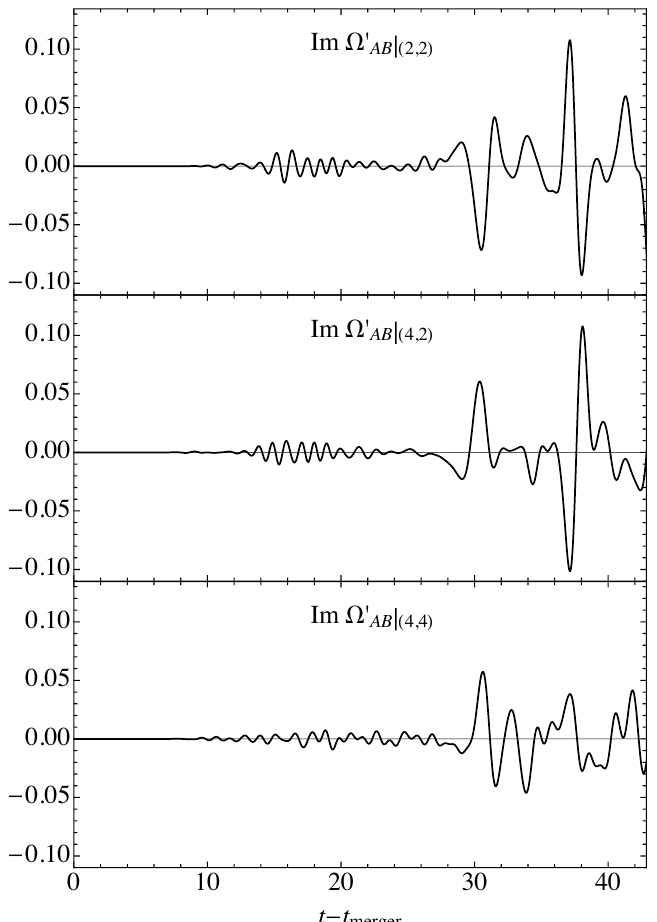
onto the harmonics Figure 7 . Imaginary part of the projection of the matrix of Weyl scalars Ω 0 AB ( ‘ ) = (2 , 2) , (4 , 2) , (4 , 4) for the collision in D = 7 . In this plot, the extraction was done at 5 , m a radius R = 30 from the center of the grid. The first peak is observed at t − t 30 , merger ∼ corresponding to the initial collision of the two BHs; the oscillations observed before this time are due to the constraint violations in the initial data and initial gauge adjustment. Two large peaks are observed in the (2 , 2) and (4 , 2) modes at around t − t 37 . 5 . This corresponds to the merger ∼ time when the dumbbell-shaped horizon stops rotating and starts expanding. Beyond this point, whilst the gravitational wave signal continues to develop new features corresponding to the onset and further evolution of the local GL instability in the neck regions, their amplitude is never as large as that of these two initial peaks. Consequently, the energy loss in absolute value